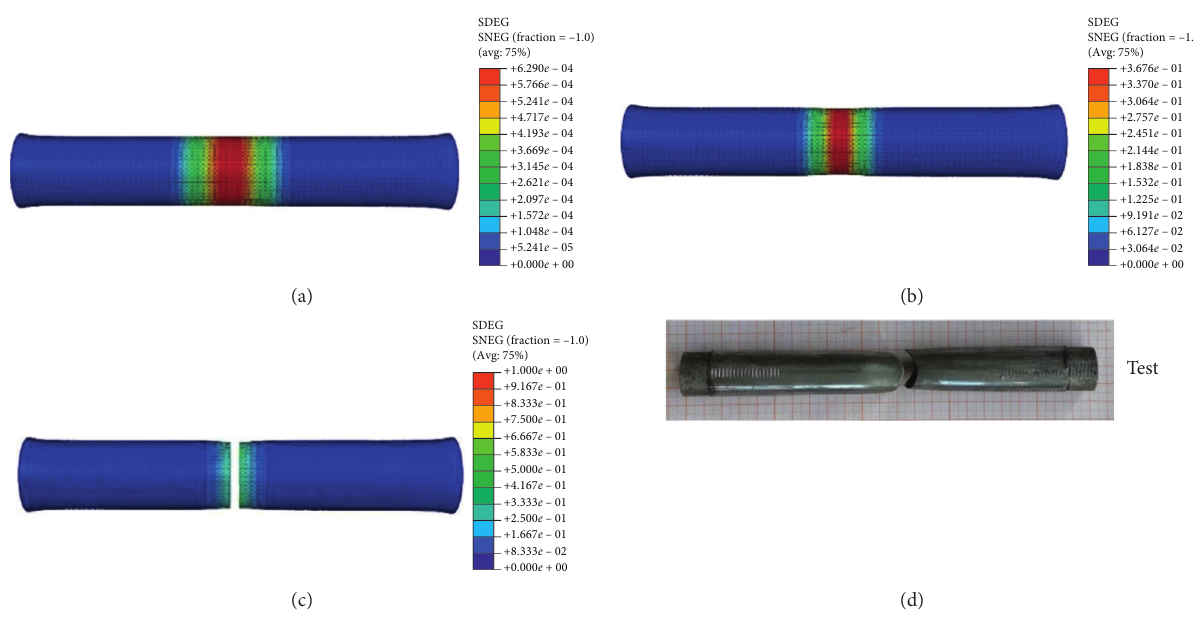
Figure 9: Evolution of fracture and failure mode of an intact pipe.